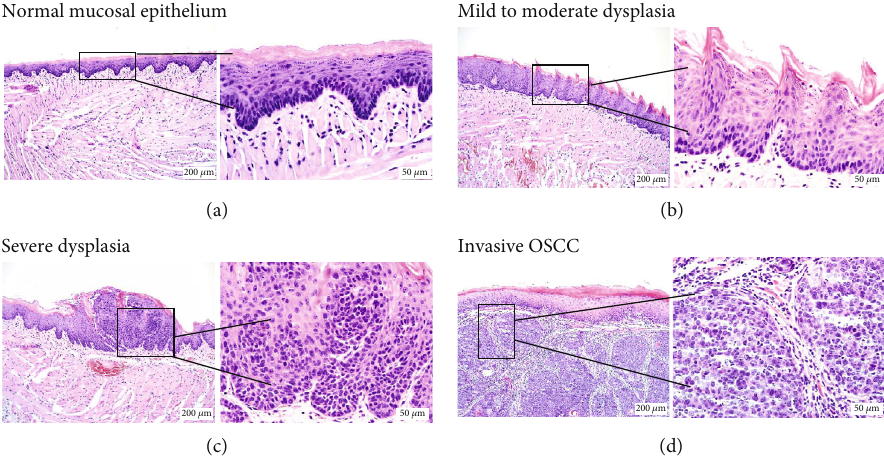
Figure 3: Histological examination of mouse tongue mucosa: (a) normal mouse tongue mucosal epithelium; (b) mouse tongue mucosal epithelium with mild to moderate dysplasia; (c) mouse tongue mucosal epithelium with severe dysplasia; (d) mouse tongue mucosal epithelium with invasive squamous cell carcinoma. Magni fi cation × 100; × 400.